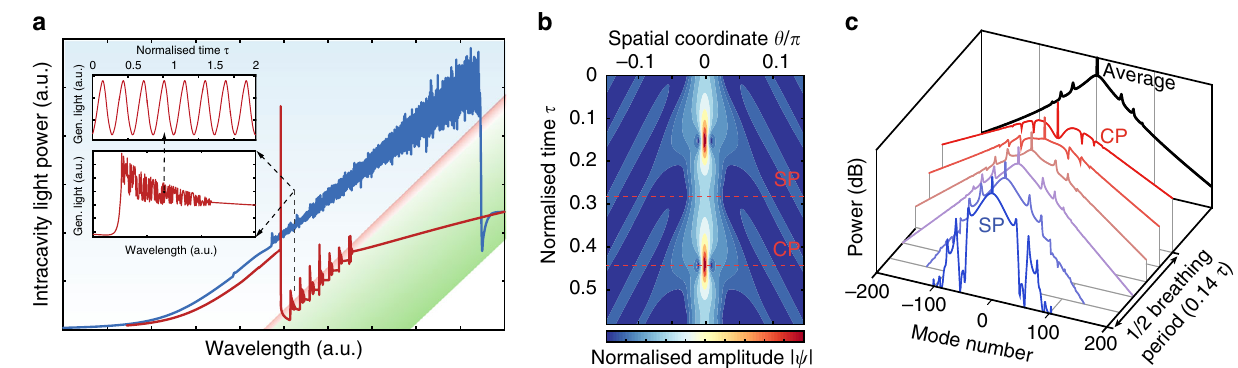
Fig. 1 Numerical simulations. a Simulation of the intracavity power, illustrating the backward tuning method used to trigger breathing. The generation of a stable multiple-soliton state is achieved by forward tuning of the pump laser ( blue curve ). The backward tuning is applied next ( red curve ) in order to reach the low-detuning boundary of the soliton existence range where the breathing regime (increased noise) and switching effect (step features) occur, allowing to transition to the single-soliton state. The blue shading corresponds to the region where modulation instability occurs, the green marks stationary solitons existence and the red area indicates breathing. The lower inset details the single soliton breathing and switching during the backward tuning. The upper inset shows the oscillations of the power for a fi xed laser frequency in the single-soliton state ( f = 21.5, ζ 0 = 27.3). b Temporal evolution of a breathing dissipative soliton over one breathing period illustrating the periodic compression ( CP ) and stretching ( SP ), both indicated by a red dashed line and the emission of waves in the background. c Corresponding optical spectrum of the intracavity pattern over half a period, showing the evolution between the maximal stretching and compression instants (SP and CP). On average, over one period, the spectrum features a triangular shape (in log scale). The emitted waves are causing the sidebands in the